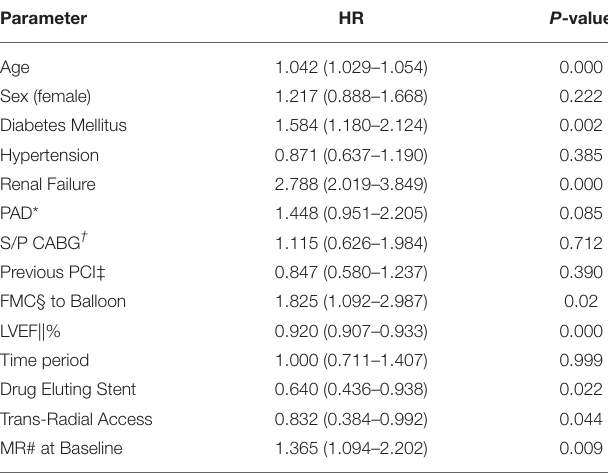
TABLE 3 | Multivariate analysis for the risk of 1-year